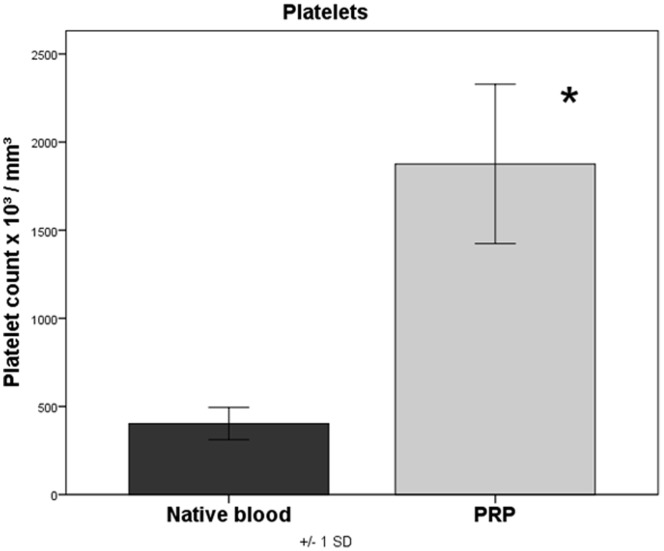
Quantification of platelets in native blood and PRP, p<0.001 PRP versus native blood.